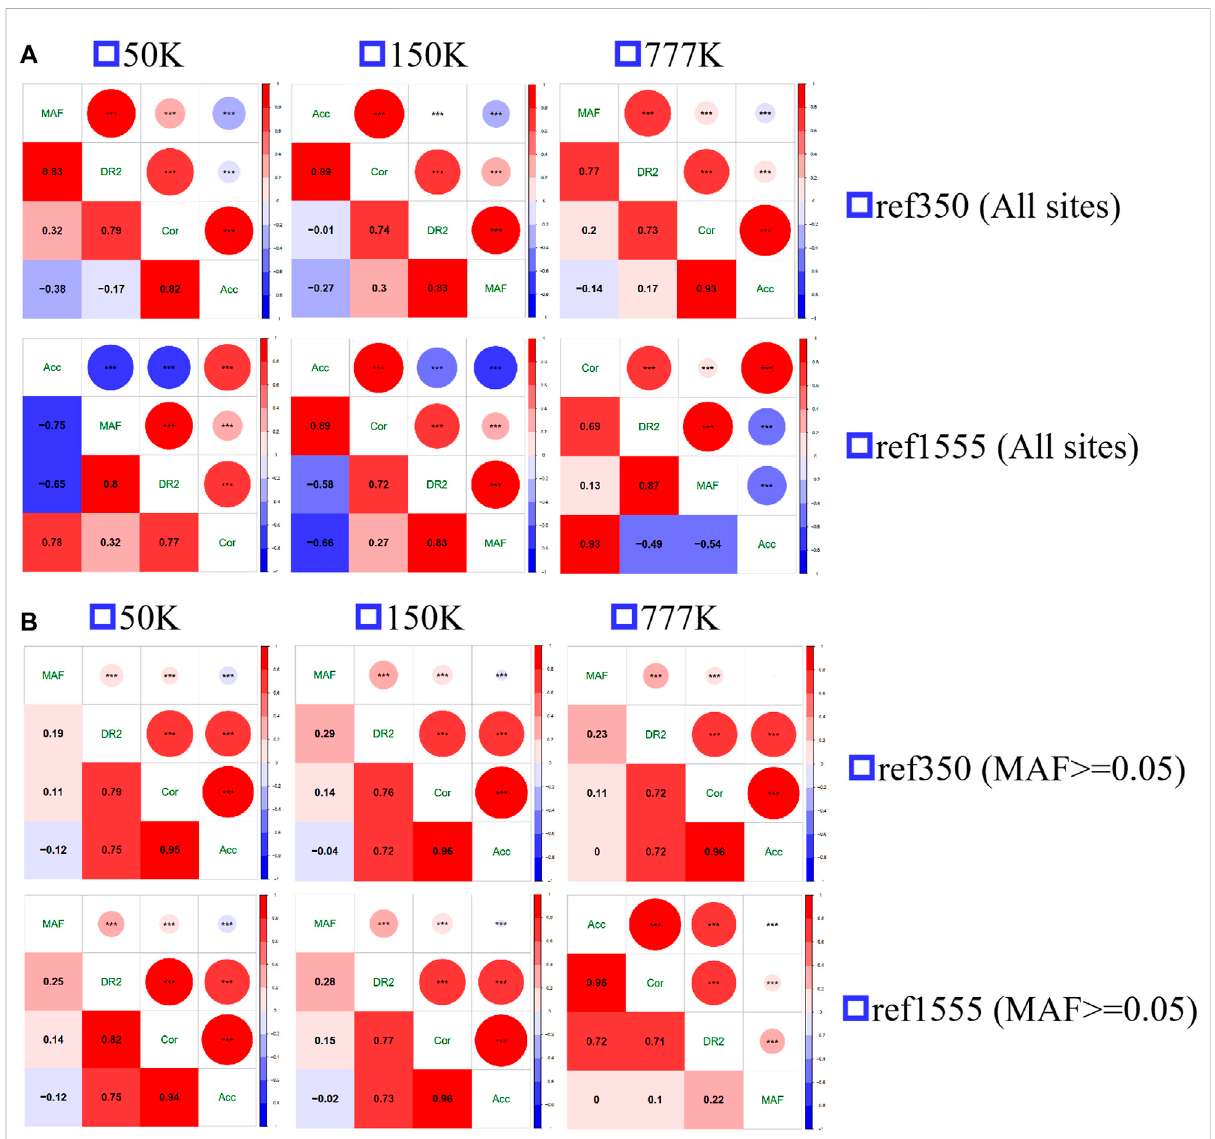
FIGURE 5 Thespearmancorrelationofthethreemeasuresofimputationaccuracyandminorallelefrequency(MAF)amongeachother. (A) Allsites (B) the sites with minor allele frequency no less than